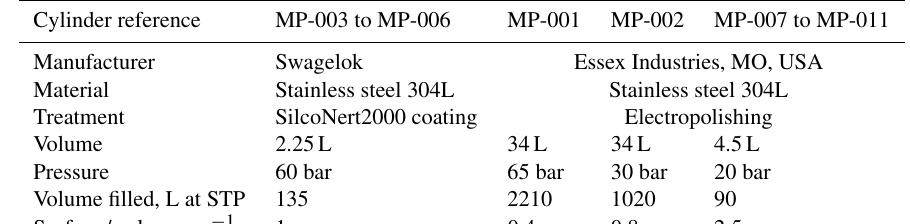
Table 1. Overview of cylinders used to store the reference gas mixtures.